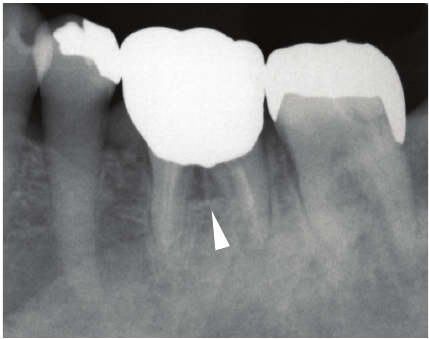
Figure 1: Dental X-ray indicated apparent furcation involvement of the left mandibular first molar.